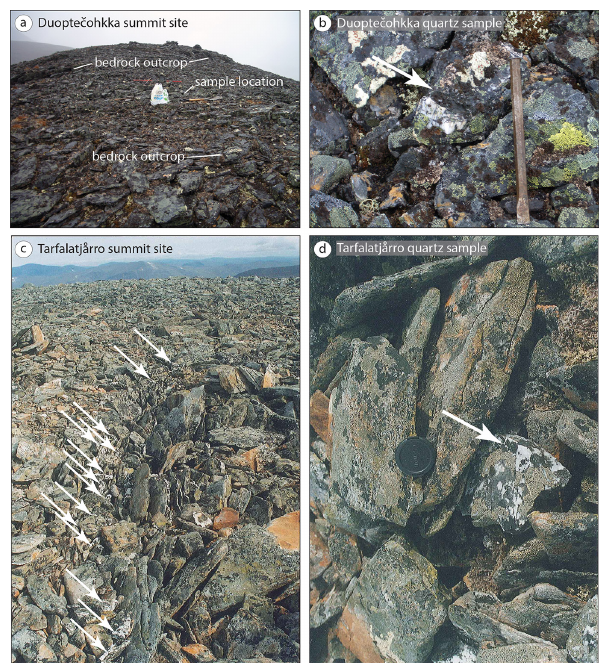
Figure 2. Sample sites for surface quartz clasts on the summits of (a, b) Duopteˇcohkka and Tarfalatjårro (c, d) . The quartz sampled on Duopteˇcohkka (arrow in b ) was an isolated mass attached to an amphibolite block whereas the quartz clast sampled on Tarfalatjårro (arrow in d ) was part of a frost-shattered quartz vein that extended ∼ 8m across the blockfield surface (arrows in c